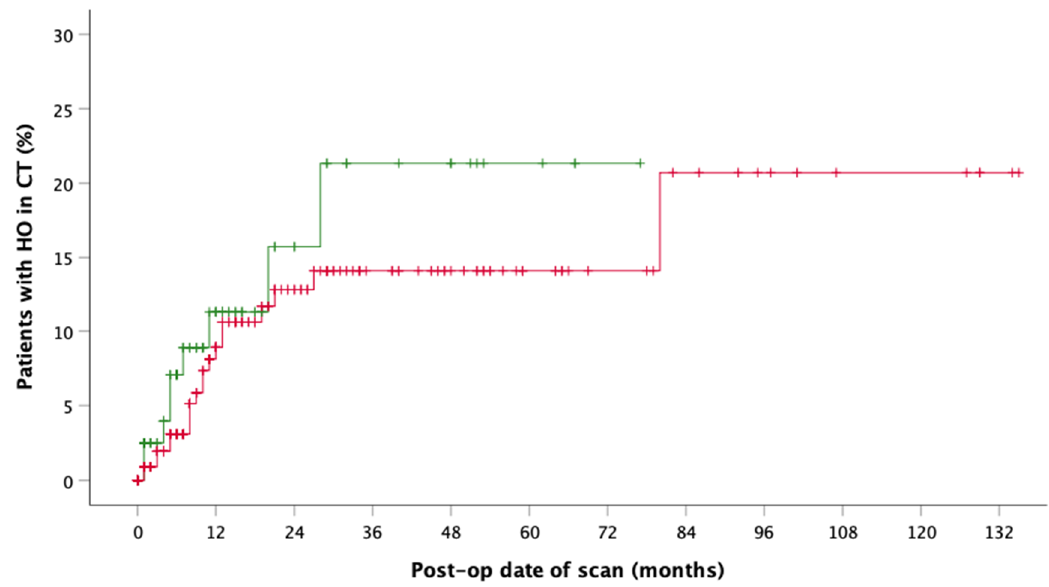
Figure 4. Incidence function shows the radiographic presence of HO by postoperative date of CT in maxillary (green, n = 9) and mandible (red, n = 20) reconstruction.